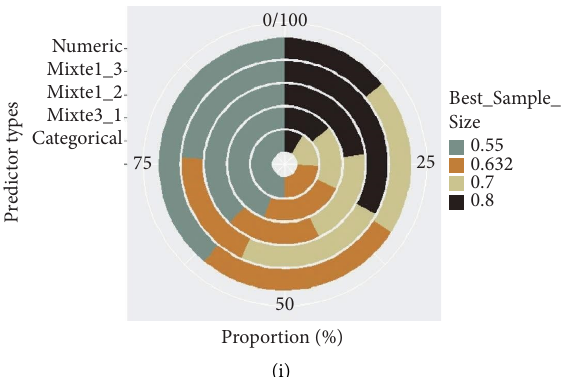
Figure 4: Best RF sample size as a function of the population size, number, and type of predictors (Numeric � 100% are quantitative predictors, Mixt1 3 � 25% are quantitative predictors, Mixt1 2 � 50% are quantitative predictors, Mixt3 1 � 75% are quantitative pre- dictors, and Categorical � 100% are categorical predictors). (a) N � 50 ,P � 8, (b) N � 250 ,P � 8, (c) N � 1250 ,P � 8, (d) N � 50 ,P � 16, (e) N � 250 ,P � 16, (f) N � 1250 ,P � 16, (g) N � 50 ,P � 24, (h) N � 250 ,P � 24, and (i) N � 1250 ,P �